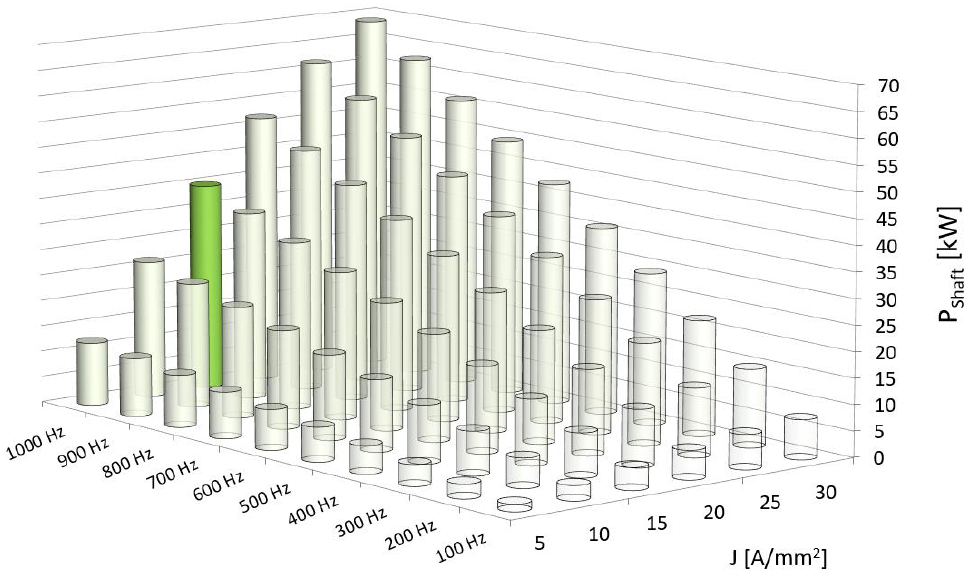
Figure 7. The value of shaft power as a function of the supply frequency and current density in the winding for M400 rotor.